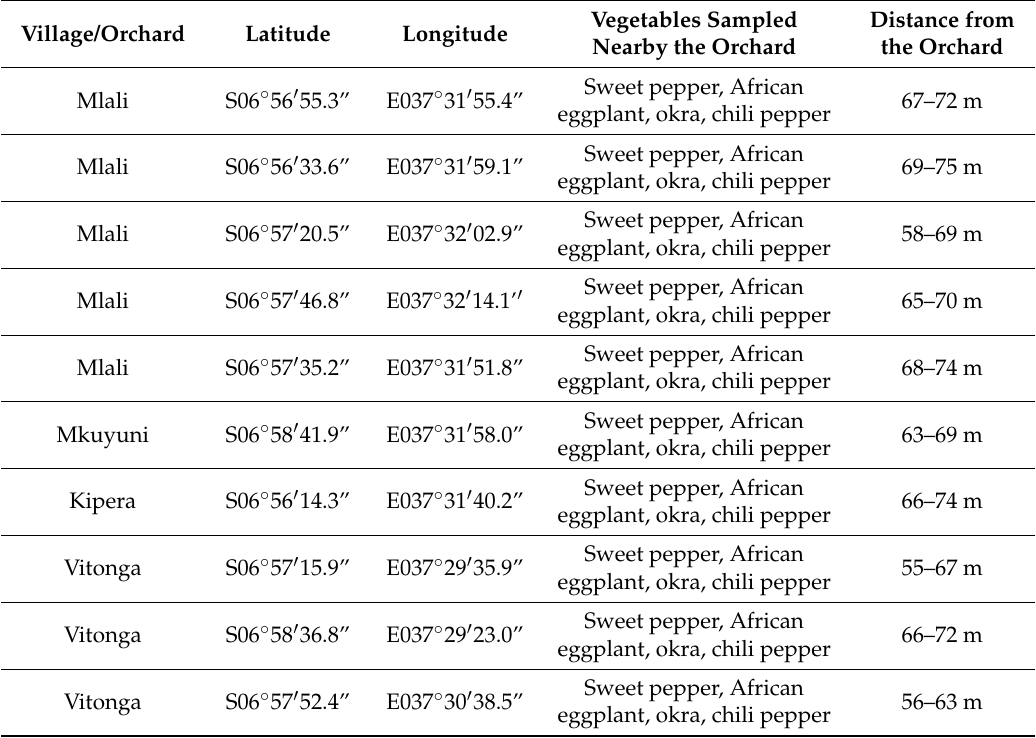
Table 1. Vegetable samples collected near citrus orchards for Thaumatotibia leucotreta incidence in mid altitude, Mlali, Morogoro,